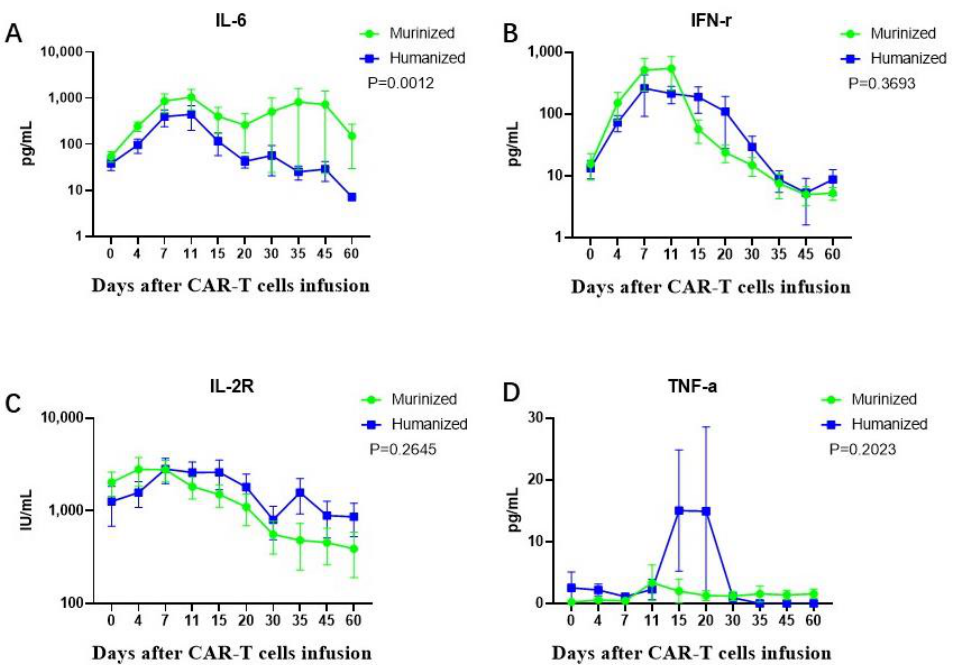
Figure 8. Comparison of cytokine levels in the murinized and humanized groups. Post CAR-T infusion, The murinized group had higher levels of IL-6 ( A ) than the humanized group ( p = 0.0012). The trend of levels of IFN-r ( B ), IL-2R ( C ) and TNF-a ( D ) were similar in the two groups. TNF-a: tumor necrosis factor alpha; IFN-r: interferon gamma.